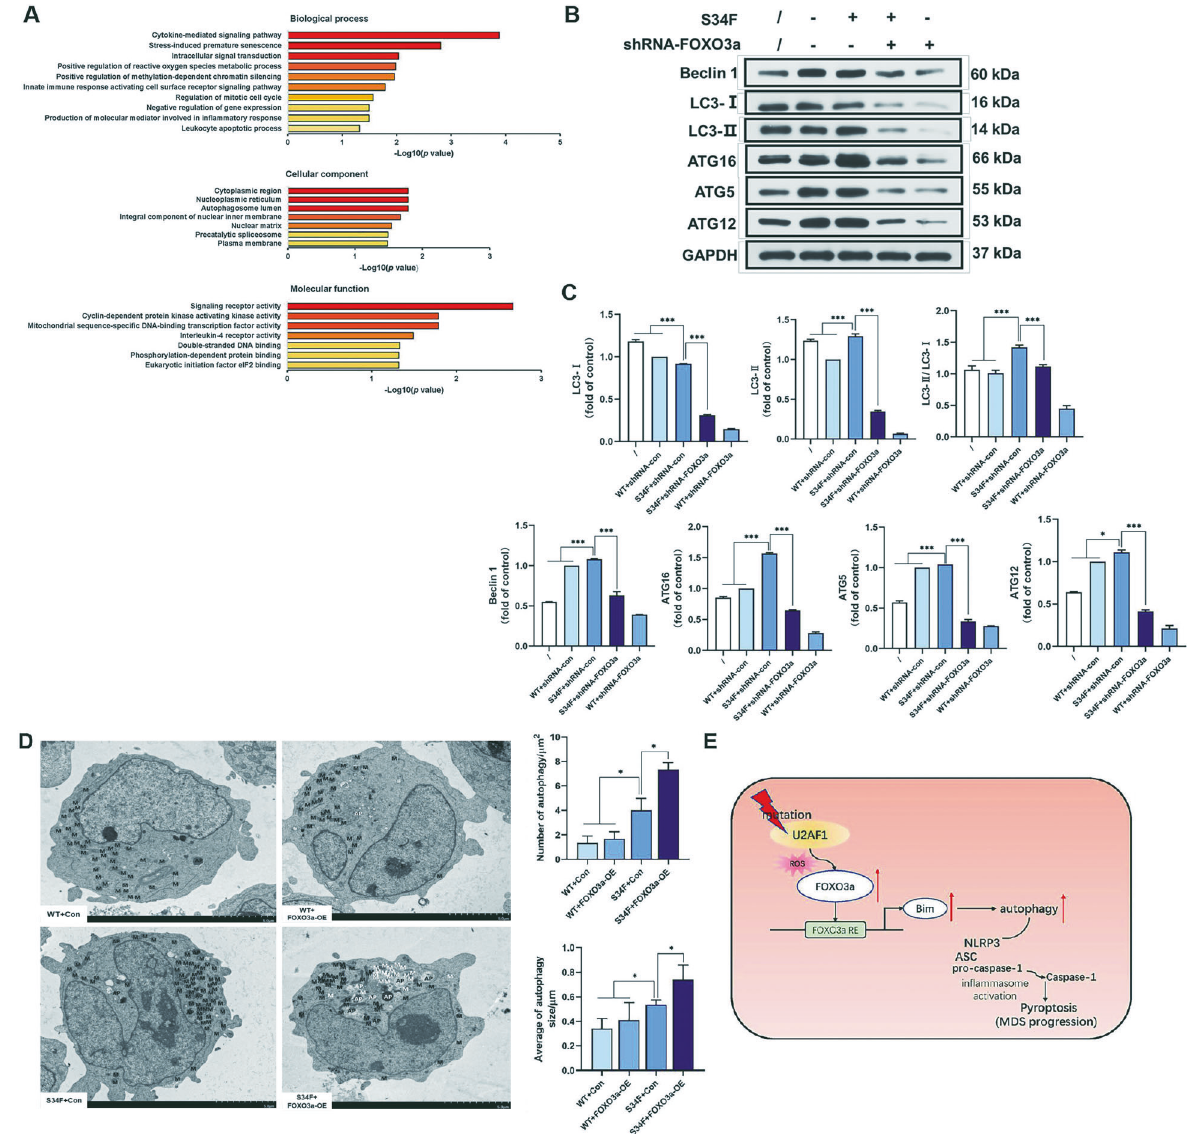
Fig. 6 Restored autophagy program as a result of FOXO3a dysregulation by U2AF1S34F mutation. A Biological process, molecular function, as well as cellular component are adopted to categorize GO. B, C Representative images of western blotting data. Quantitative analysis of the protein expression levels, and the LC3-II/ LC3-I ratio is demonstrated. Beclin 1, ATG5, ATG12, and ATG16 complex proteins were all up-regulated following S34F mutant U2AF1 treatment. These proteins were decreased after silencing of FOXO3a. D Representative transmission electron micrographs of autophagosomes ultrastructure. Scale bar, 5 µm. E Schematic representation of the potential role of U2AF1 S34F mutation based on this study. The data represent at least two independent experiments with three samples per group in each. * p < 0.05, ** p < 0.01, and *** p < 0.001. WT, wild-type, M mitochondria, AP